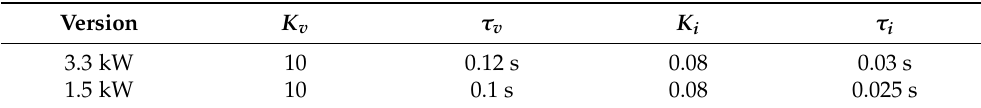
Table 10. Parameter values for DC–AC full bridge PI